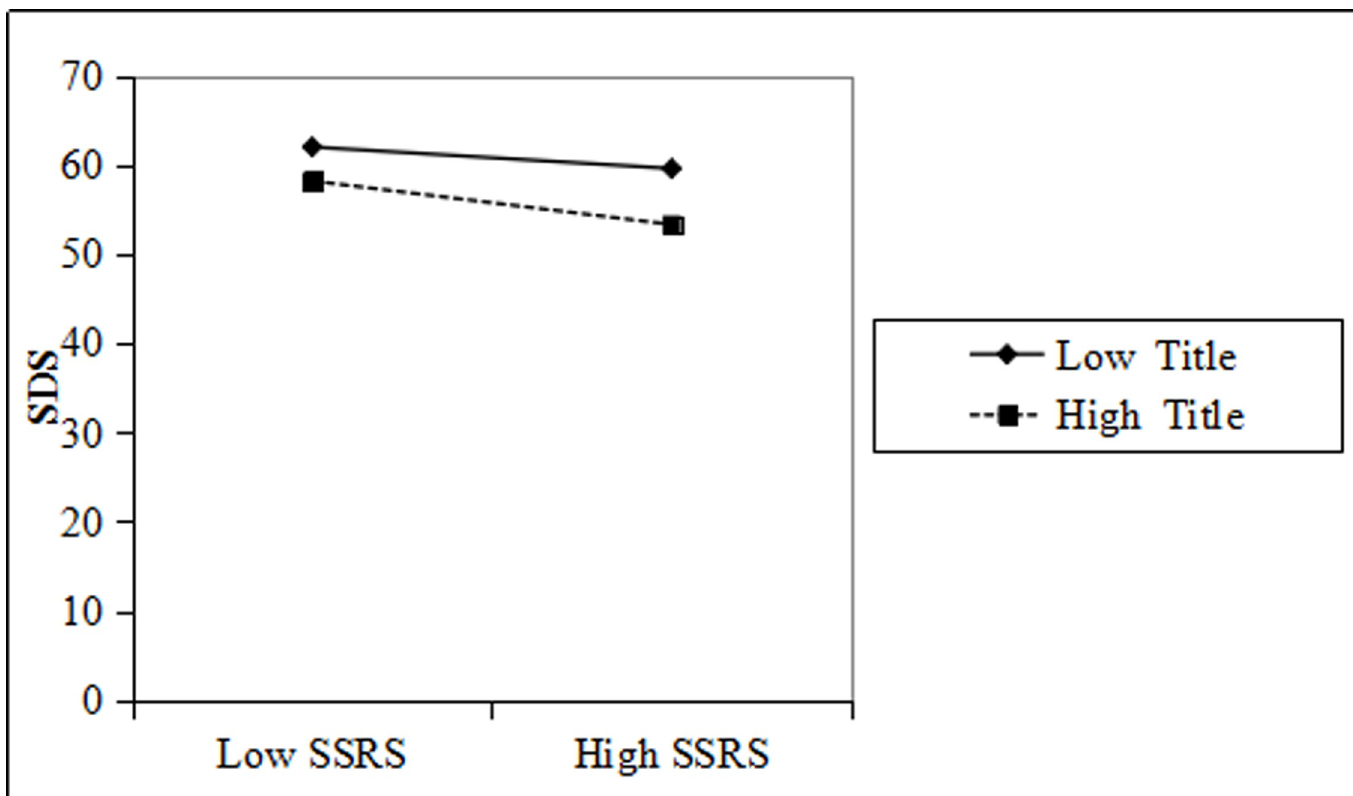
Fig 5. Title moderation interaction diagram for SSRS and physician SDS.